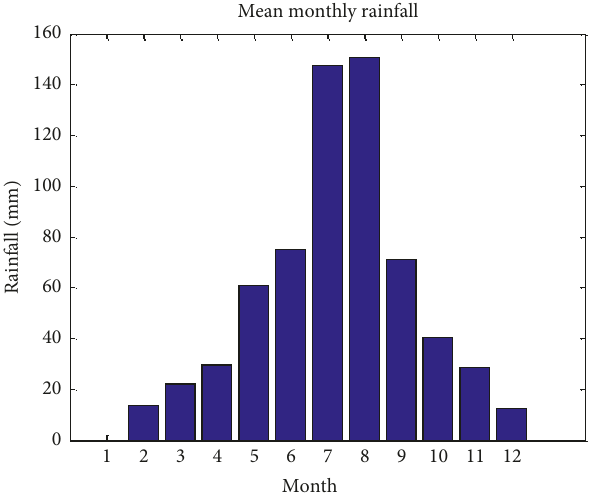
Figure 1: Histogram of the mean monthly rainfall in Qingdao, China.